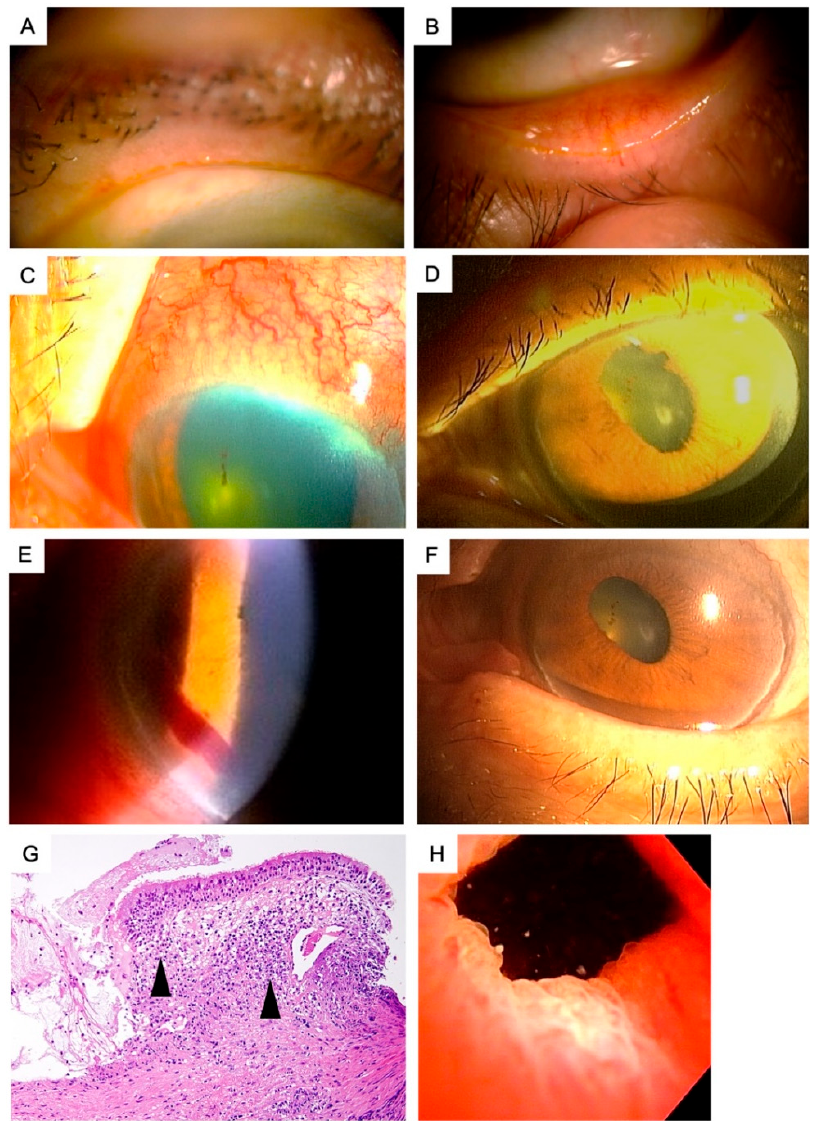
Figure 1. Anterior segment findings, nasal mucosal histopathology and bladder apex findings in patient with atypical Granulomatosis with polyangiitis. ( A – B ) slit lamp anterior segment findings at the initial visit. Note the presence of pouting and meibomian gland orifice obstruction, lid margin telangiectasia and turbid nature of meibum (OS). ( C – D ) The slit lamp anterior segment findings at the second week of follow up. Note the scleritis and marked conjunctival injection ( C ), the anterior chamber inflammation and anterior synechiae ( D ), and the anterior chamber bleeding presumably due to vasculitis of iris vessels ( E ). ( F ) The slit lamp anterior segment findings at the final visit. Note the absence of ciliary injection, lack of anterior chamber inflammation and meibomian gland dysfunction. Iris pigment deposits was remained on the anterior lenticular surface after relieving the anterior synechiae with mydriatics. ( G ) Nasal mucosal histopathology specimens. Note the mucosal and submucosal inflammatory cells (arrow heads) consisting mainly of neutrophils in the Hematoxylin and Eosin stainings. ( H ) The digital photograph of the bladder apex during trans urethral resection. Note the epithelial multifocal papillary tumors.